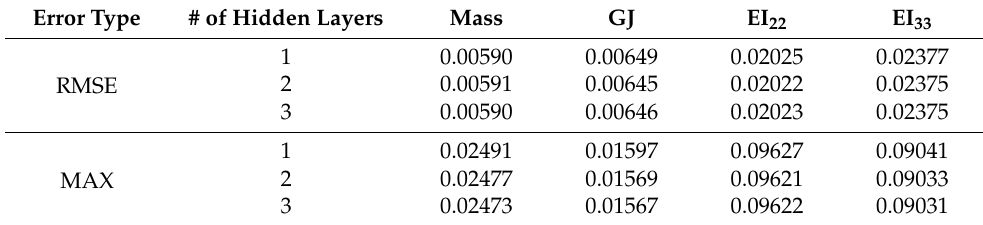
Table 6. Results of accuracy according to variation of hidden